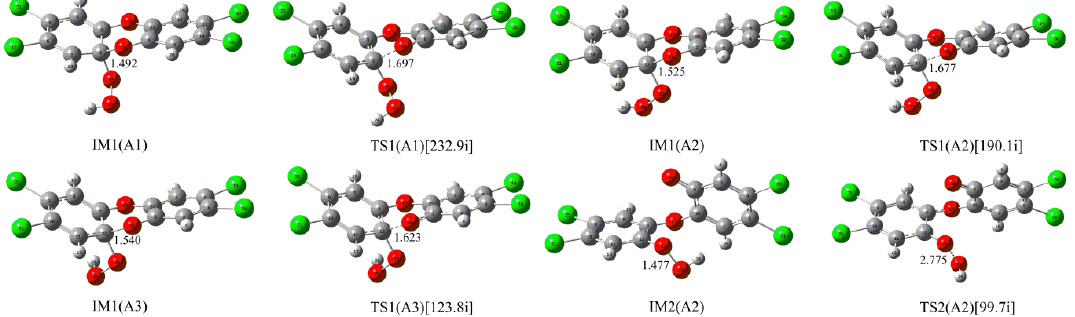
Figure 5. Optimized IMs and TSs in the nucleophilic addition reaction of HO 2− with